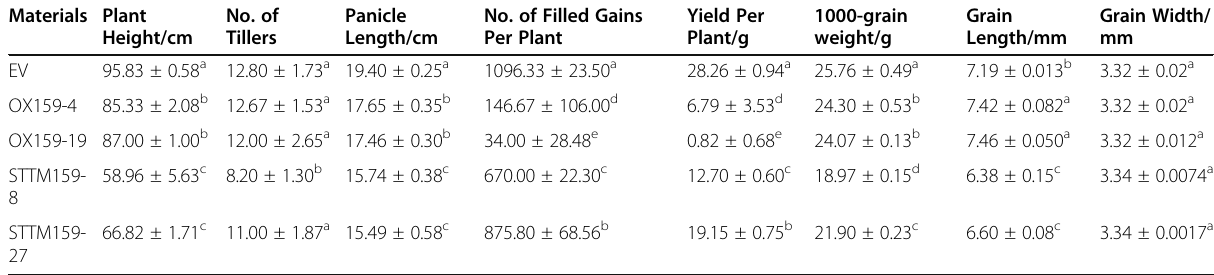
Table 1 Yield traits of the wild type, OX159, and STTM159 lines grown in rice paddies * Materials Plant